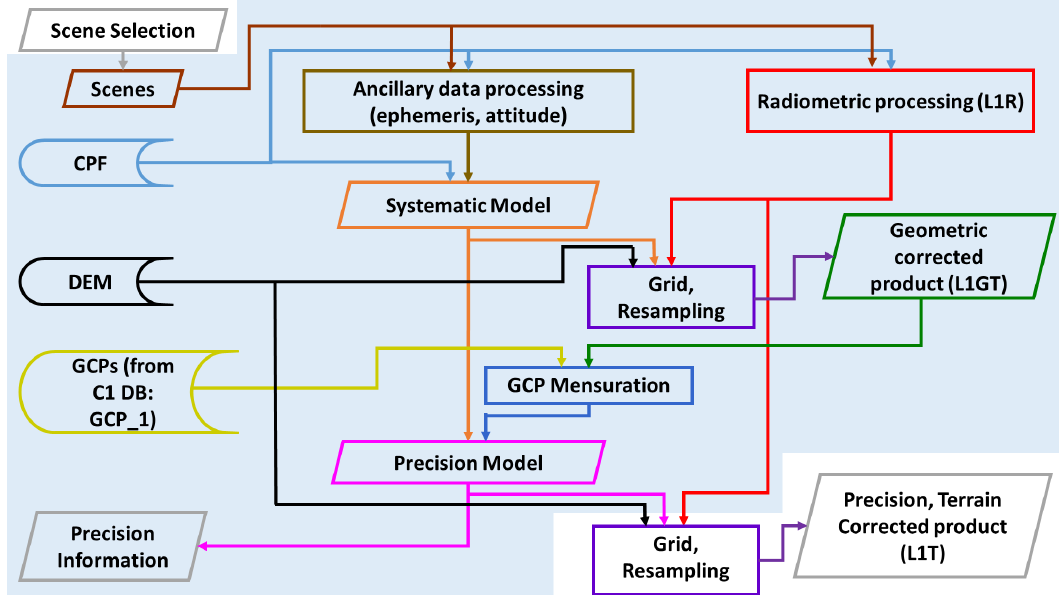
Figure 4. A simplified version of the Landsat process flow for generating terrain-corrected products. The shaded (transparent blue) portion shows the algorithm used in the precision correction process. Each input, output, and process shape is color-coded, and the arrows from them are also color-coded for ease of understanding. For example, a Calibration Parameter File (CPF) stores the calibration parameters and, therefore, is shown using the corresponding flowchart shape with a blue border. The CPF is used in ancillary data processing, systematic model generation, and in the radiometric processing, and is therefore shown in blue